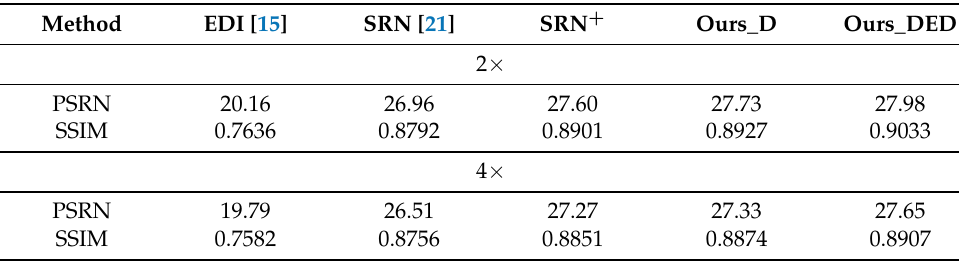
Table 2. Image deblurring results of RGB_DAVIS in terms of average PSNR and SSIM. SRN and SRN + represent the results of image deblurring without and with low-resolution events, respectively, while Ours_D and Ours_DED represent the results of our method without and with EventSRNet, respectively. This shows that the proposed method outperforms the methods from previous works and image deblurring can benefit from the -spatial resolution events and event-enhancing operations.